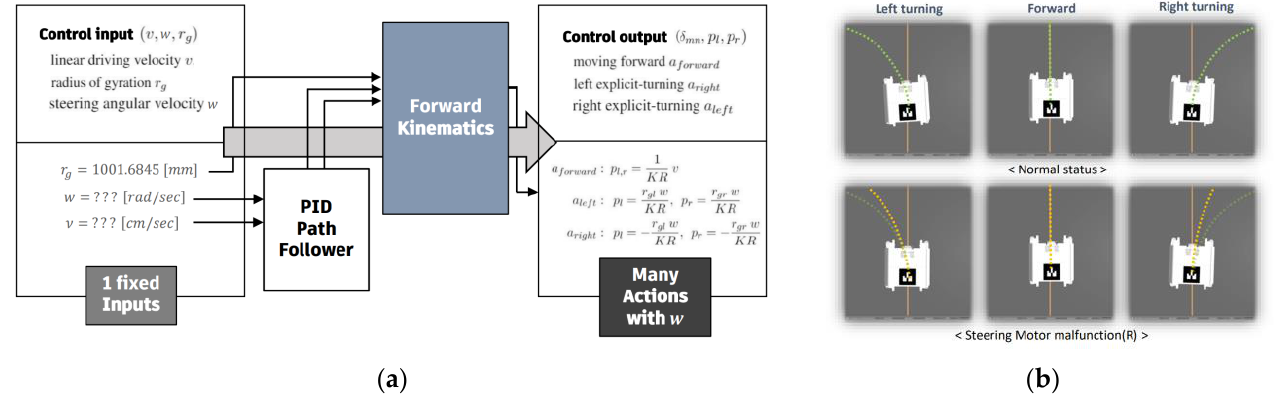
Figure 20. Approximated forward kinematics used for rover locomotion control in the PID. ( a ) Input parameter setting to define actions. ( b ) Gyration paths for the rover ’ s three steering motions in a normal state (upper) and in steering motor malfunction (lower).